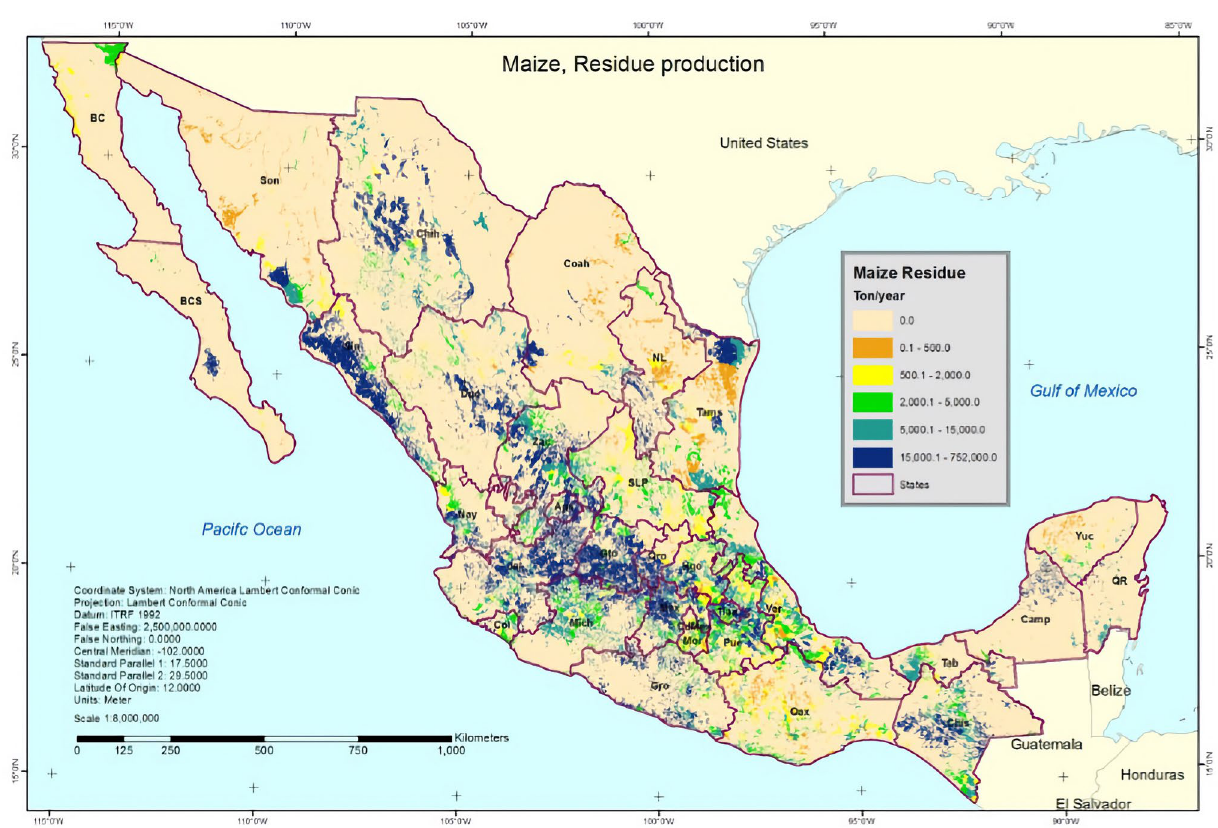
Fig. 1 Average estimated production of Corn stover (Mg/year) assigned to agricultural areas within each municipality for the years 2009–